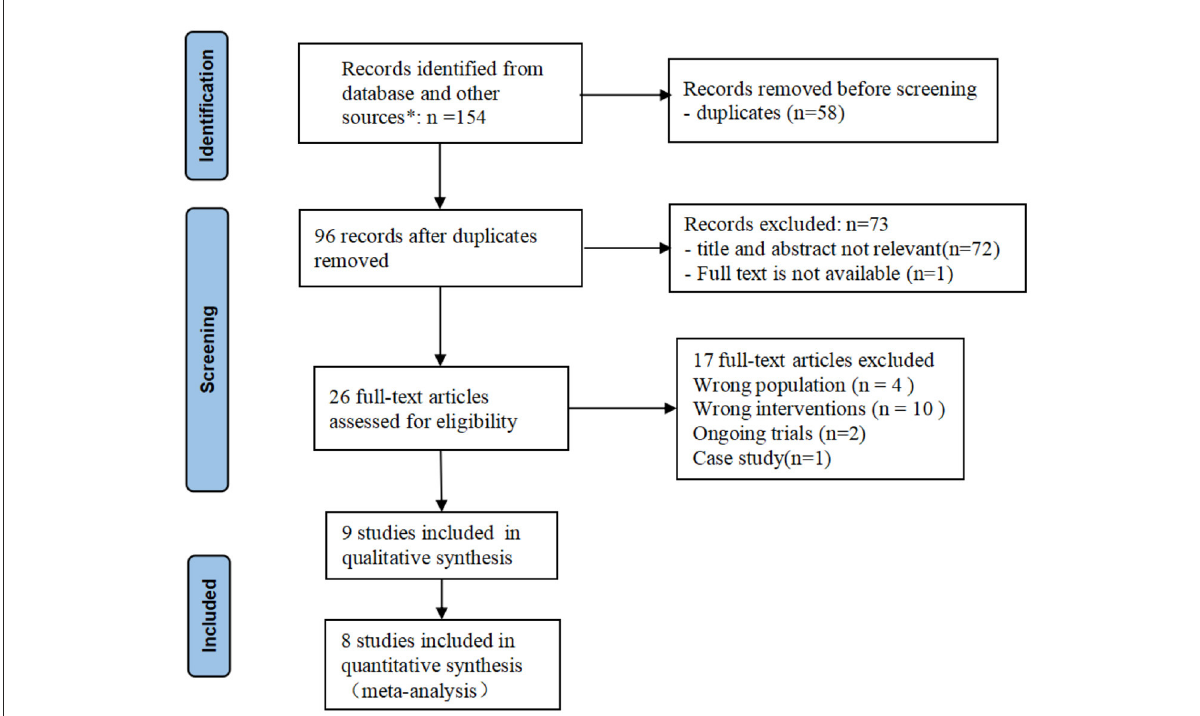
FIGURE1 PRISMA flow diagram of study selection. *The number of records identified from each database searched: Cochrane Library: n = 11; Pubmed: n = 11; Web of science: n = 37; EMBASE: n = 27; CINAHL: n = 12; CBM: n = 2; CNKI: n = 35; WanFang: n = 13; VIP: n =